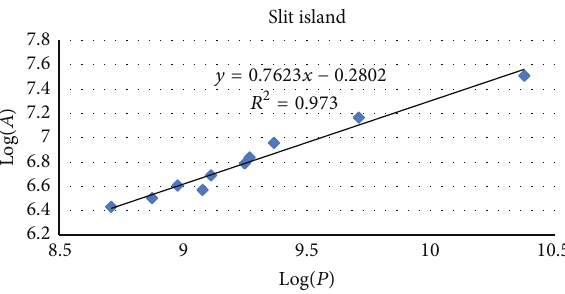
Figure 3: Determination of surface fractal dimension from the slope of the regression line on scatter-plot of logarithmic area versus perimeter [11].